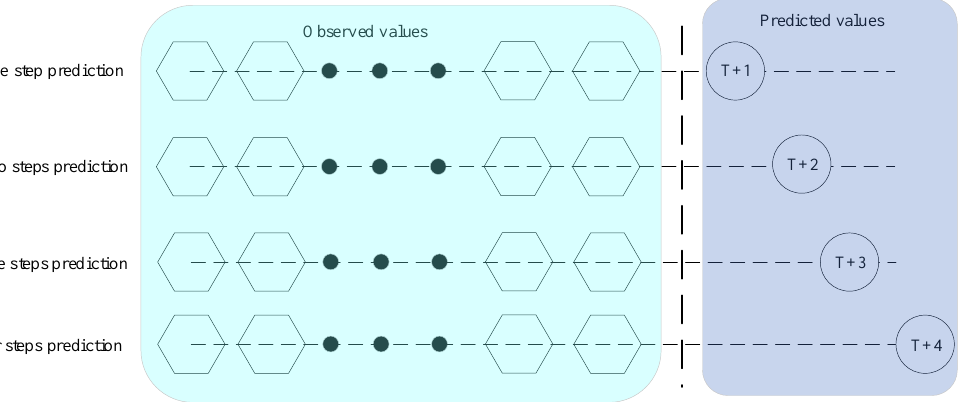
Figure 1. The framework of direction strategy